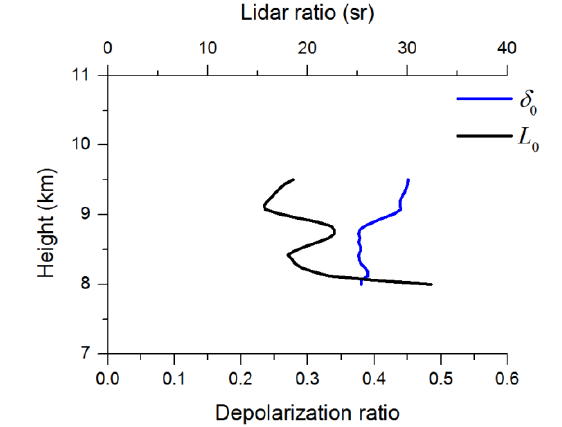
Figure 2. Case 1: Vertical profiles of the depolarization and lidar ratios We note that the values